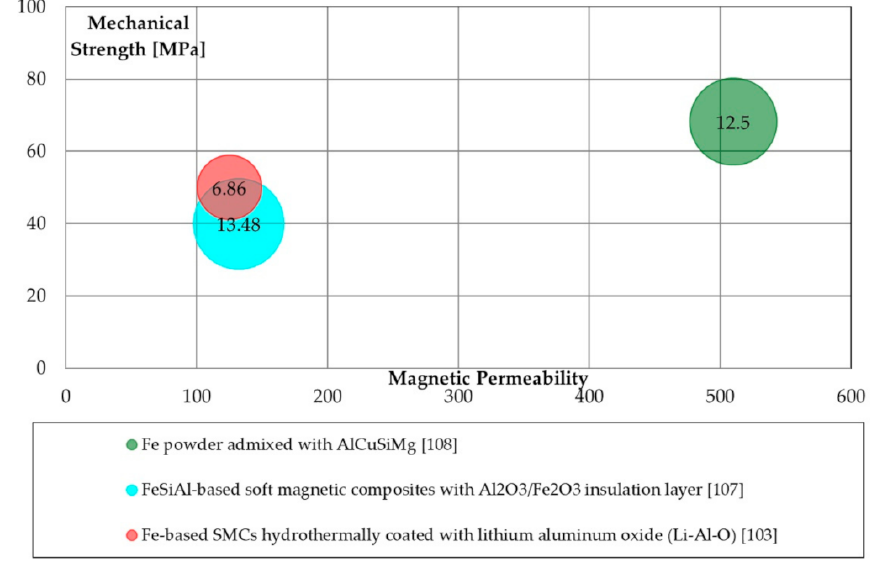
Figure 5. Magnetic (maximum permeability), mechanical (TRS [MPa]), and energetic properties (total iron losses 1 T@50 Hz [W/kg]) of alumina and aluminum alloys coating